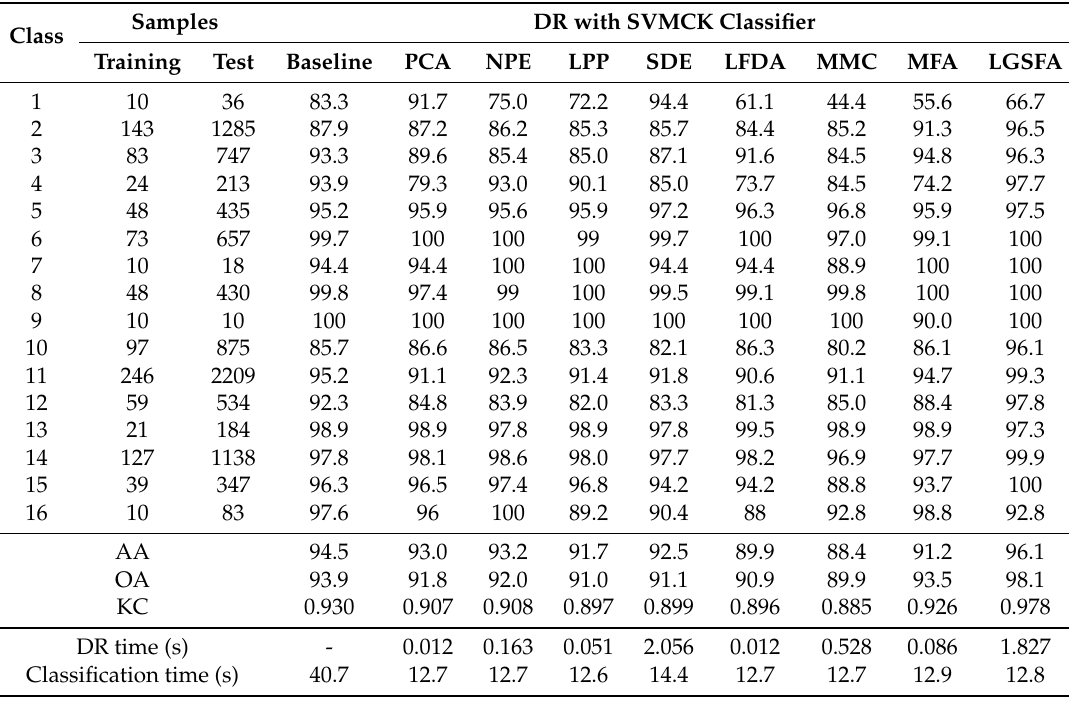
Table 4. Classification results of different DR methods with SVMCK on the Indian Pines data set.